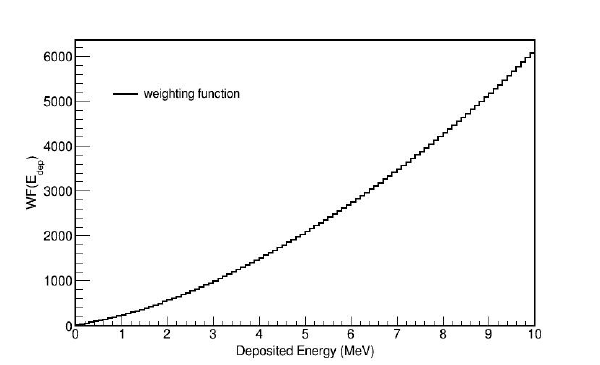
Fig.7 The weighting function of the C 6 D 6 detector for 0.2 mm thick 197 Au disc.